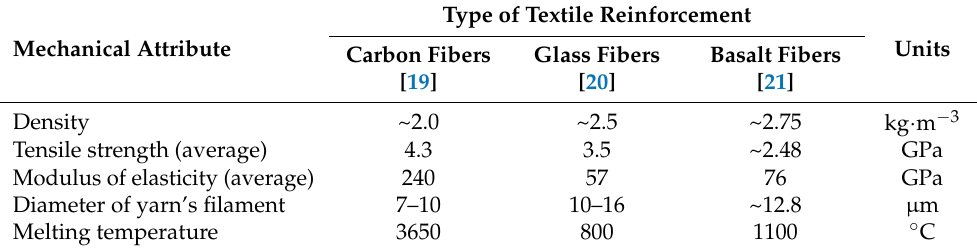
Table 1. Comparison of mechanical properties and melting points of selected textile reinforcement